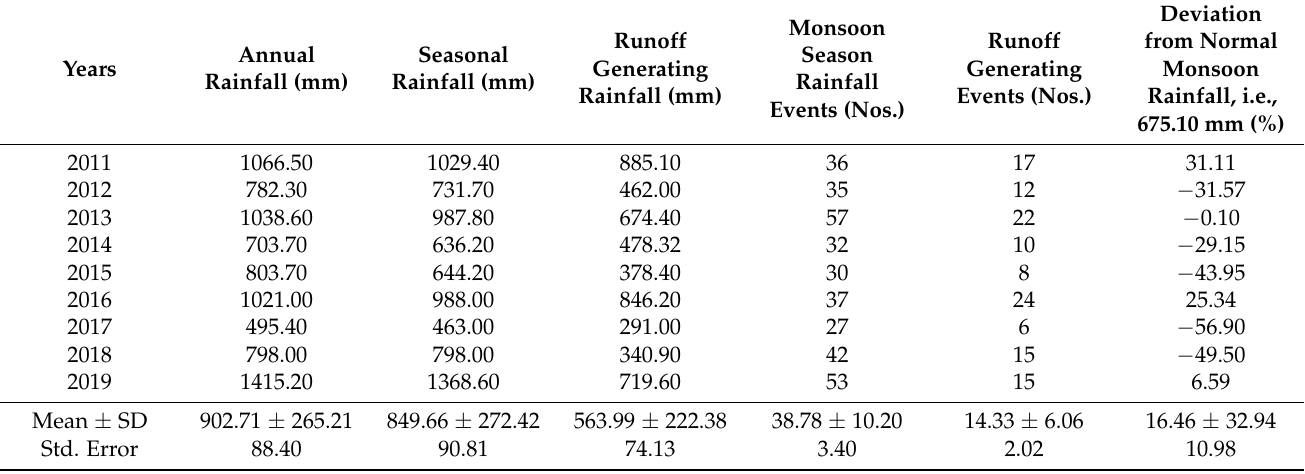
Table 2. Annual, seasonal and runoff generating rainfall (mm) and runoff producing events during the experimental period